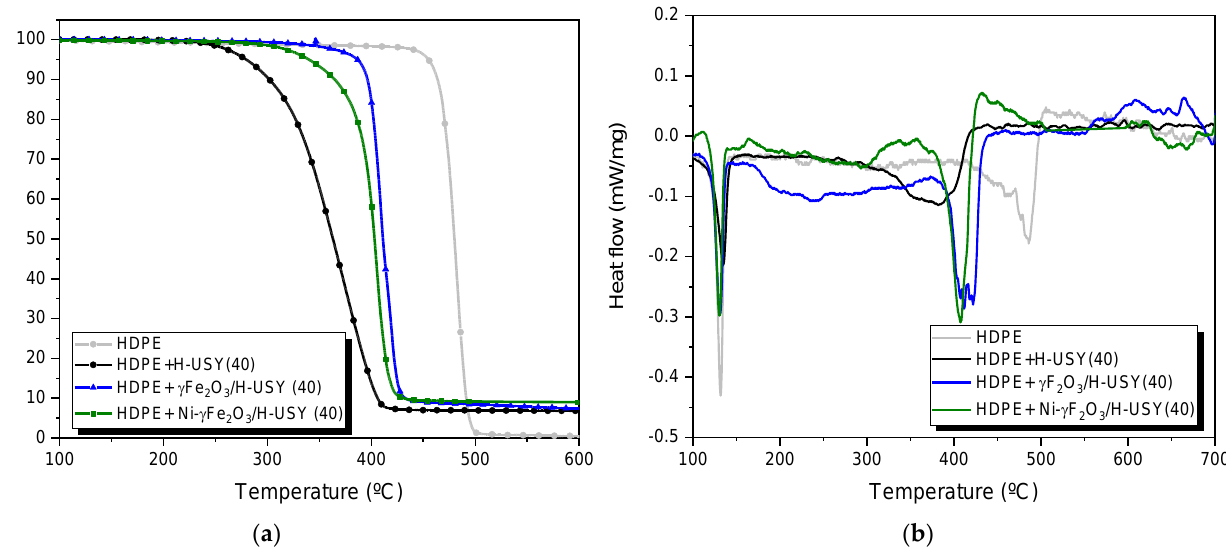
Figure 3. ( a ) XRD patterns of parent and MNPs impregnated H-USY(40) zeolites; ( b ) Magnification.